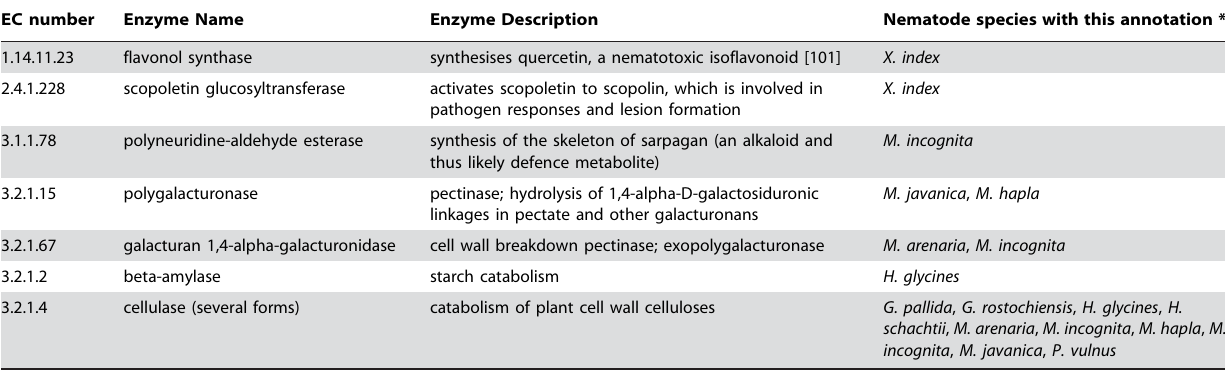
Table 1. Plant-like enzymes identified in nematode